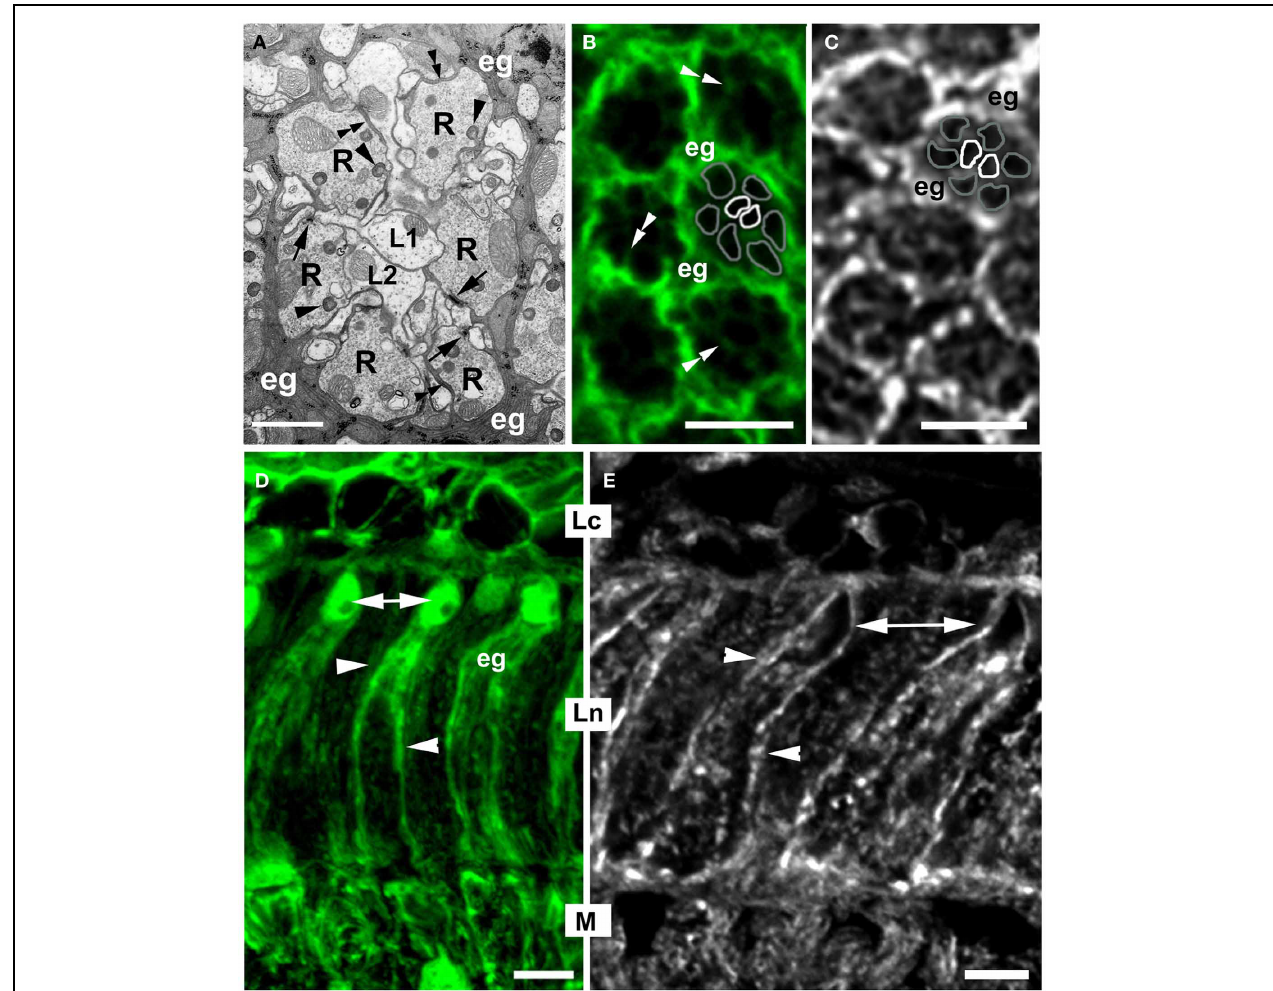
FIGURE 2 | The morphology of the cartridge in cross- (A–C), and longitudinal (D,E) section of Drosophila melanogaster first visual neuropil or lamina. (A) EM microphotograph of a single cartridge. The cylindrical terminals of six photoreceptors (R) surround axons of their main target cells, the L1 and L2 lamina interneurons, the so called large monopolar cells (LMCs). Apart from these, each cartridge hosts also smaller processes (not marked) of two more photoreceptors, R7 and R8, and three other monopolar cells, L3–L5, as well as profiles of amacrine cells, whose cell bodies are located in the second visual neuropil or medulla, and tangential neurons with cell bodies in other parts of the brain. Each cartridge is enwrapped by three cells of epithelial glia (eg) that send small processes into the cartridge (double arrowheads) and deep, dynamic invaginations with a spherical head, called capitate projections (arrowheads) into photoreceptor terminals. R-terminals contain profiles of presynaptic ribbons (T-bars) of the tetrad synapses (arrows), the most abundant type of synapses in the lamina. They constitute approximately 59% of the total number of all synapses of a cartridge (Meinertzhagen and Sorra, 2001). These synapses transmit photic and visual information received by ommatidia toward the brain. Scale bar: 1 μ m. (B) Confocal image of the cartridges of Repo-Gal4 × UAS-S65T-GFP